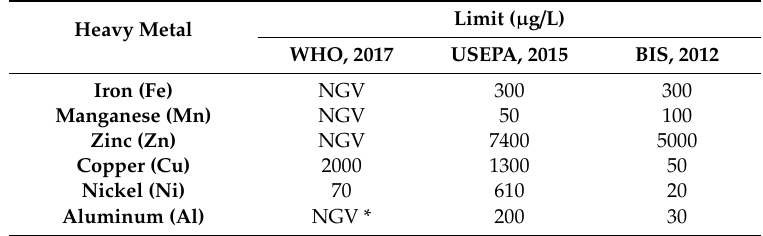
Table 5. Drinking water standards for the most frequently used metals in catalytic ozonation processes